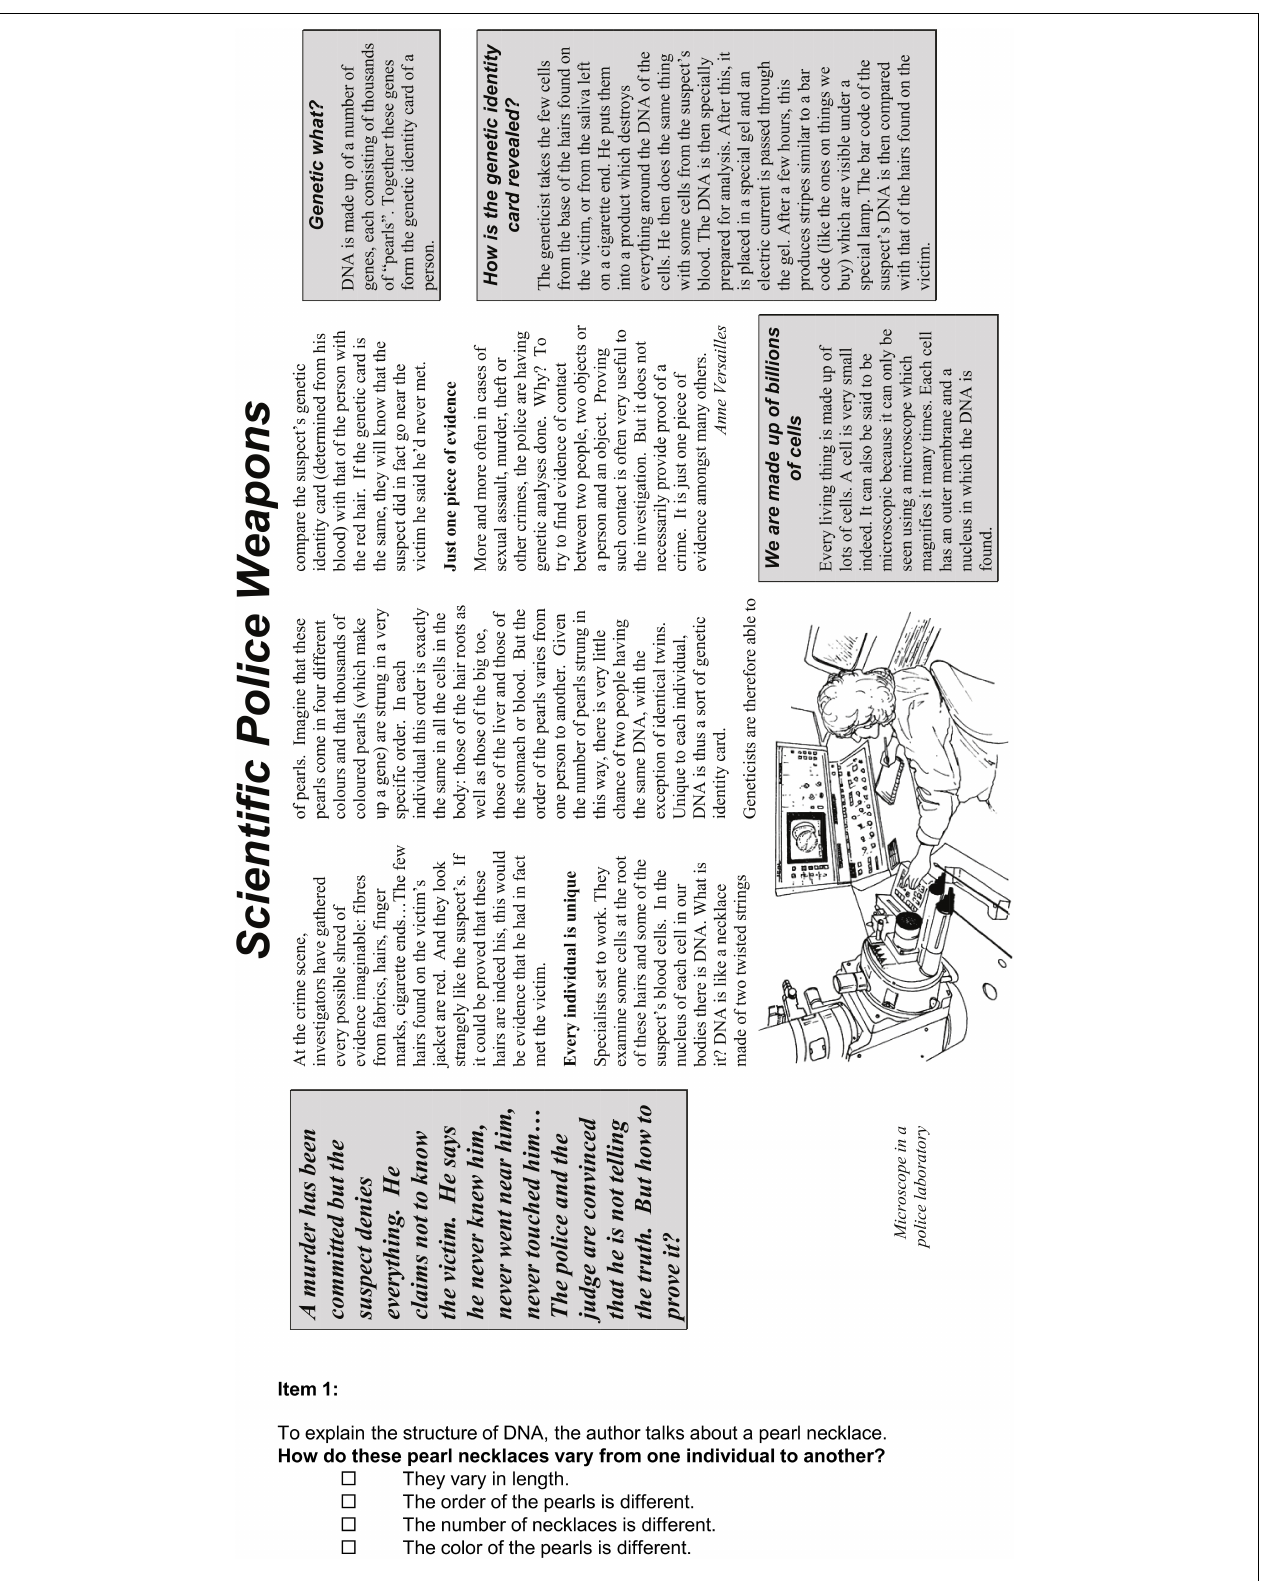
FIGURE 4 | Reading task “Police” [with one out of 4 questions; from Organisation for Economic Co-operation and Development (OECD), 2003].